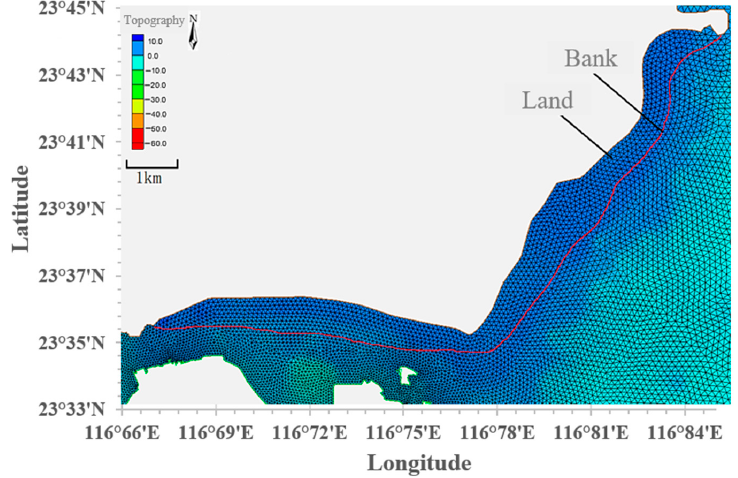
Figure 7. Urban coastal grid expansion (The red line in the figure is the original shoreline, the dam is set in the model, and its height is set to be 1.5 m higher than the average sea level). Figure 8 shows the distribution of water level and flow field in the Shantou sea area and the inundation of storm surge on the coast and land under the southeast-northwest route during the 10-year return period of typhoon storm surge. The center of the typhoon landed in Chenghai District, Shantou City. Under this path, the hurricane hit Shantou City head-on, which has an excellent representative significance. The simulation time is 72 h, of which 48 to 72 h is the transit time of typhoons.